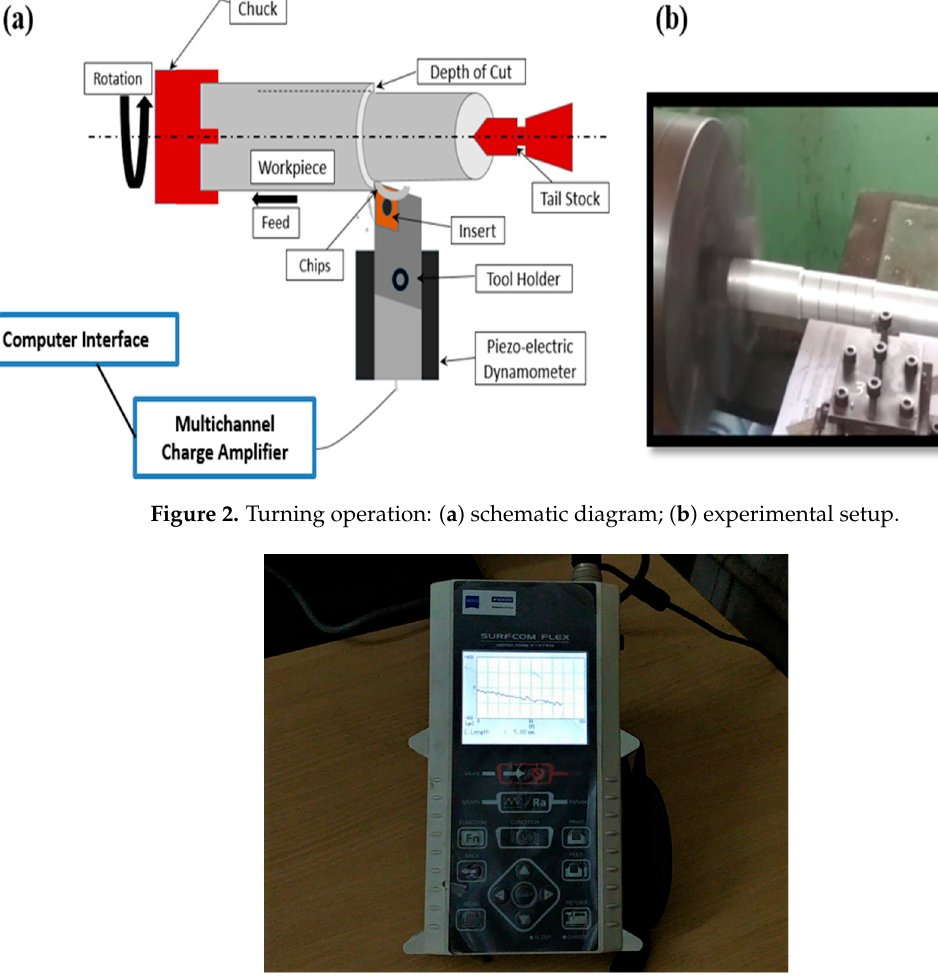
Figure 3. Surfcom flex reading screen. Table 1. Input machining parameters and their different levels.